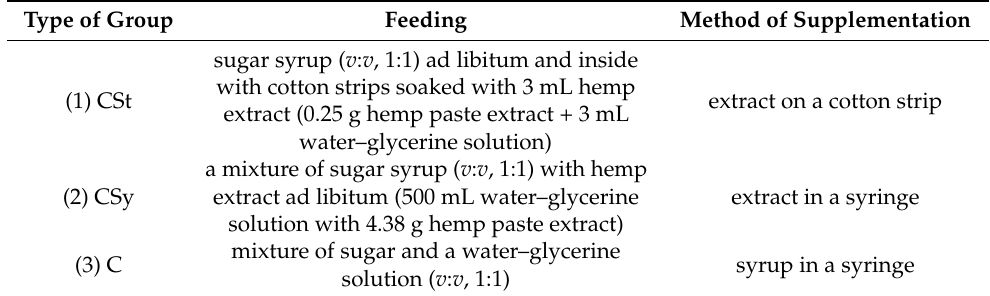
Table 1. Descriptions of supplementation and administration methods for the group in the experiment. Type of Group Feeding Method of Supplementation sugar syrup ( v : v , 1:1) ad libitum and inside with cotton strips soaked with 3 mL hemp extract on a cotton strip extract (0.25 g hemp paste extract + 3 mL water–glycerine solution) extract in a solution with 4.38 g hemp paste extract)